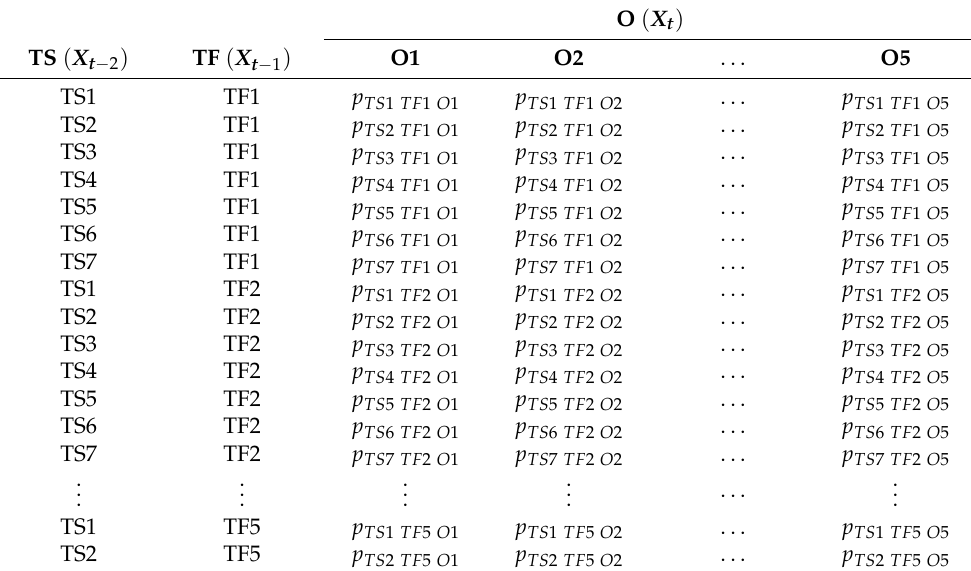
Table 4. Transition probability matrix of the second-order Markov chain in reduced